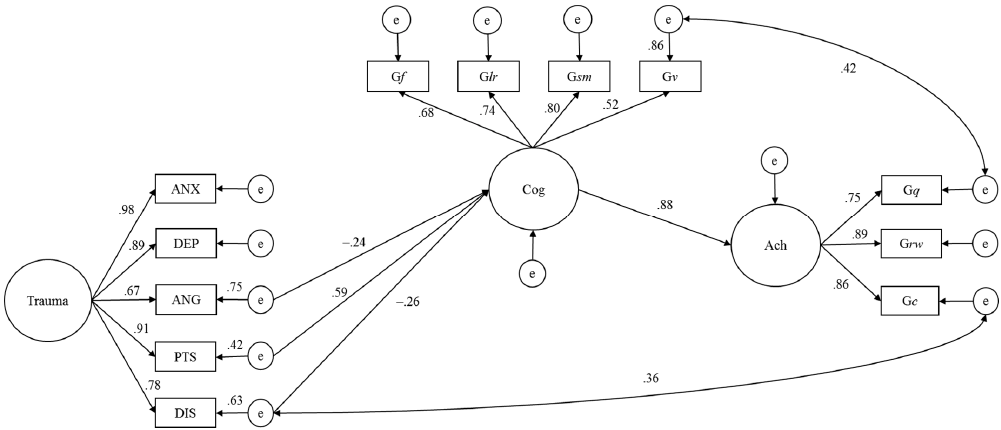
Figure 1. Final covariance structure model representing the relationships from trauma symptoms to academic achievement intervened by cognitive functioning: All paths are significant ( p < 0.05).